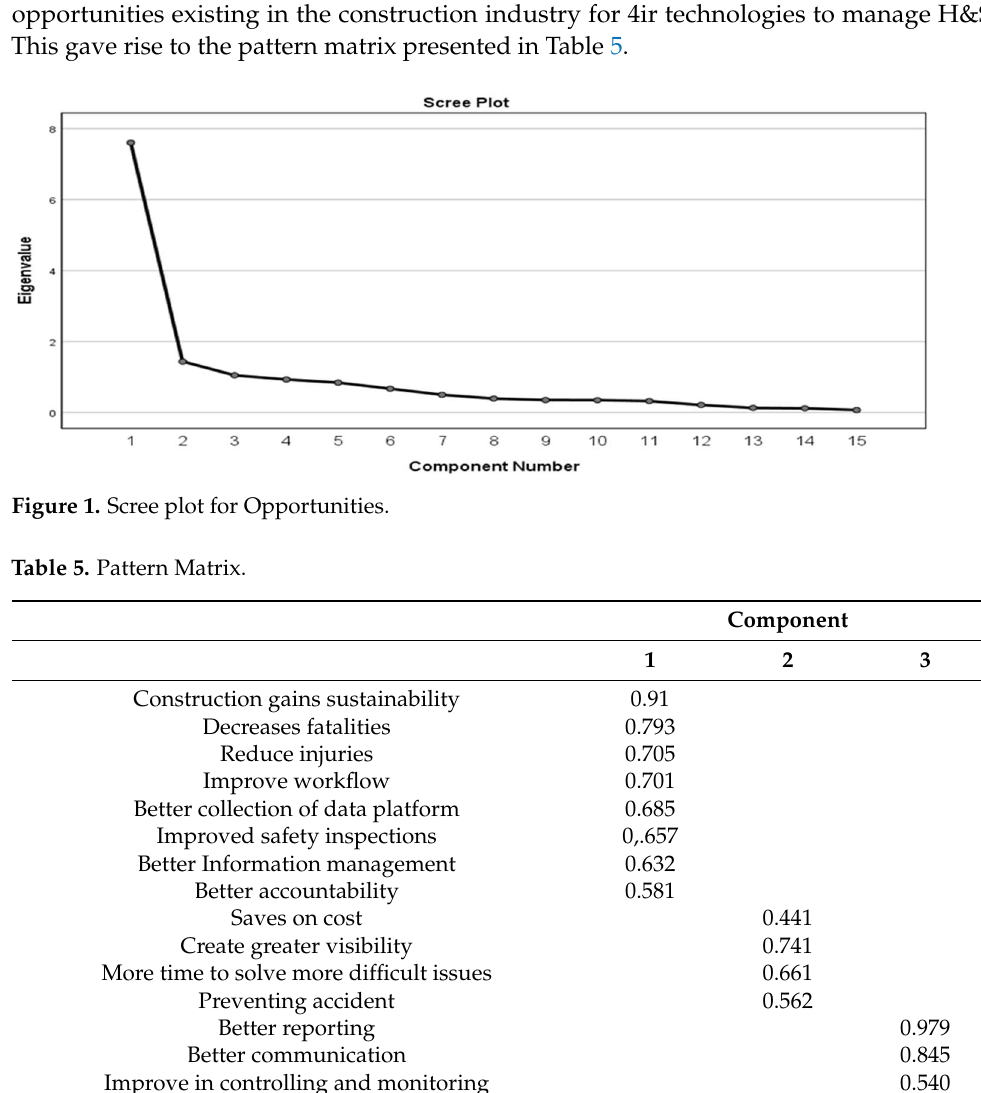
Table 4. Total Variance Explained.